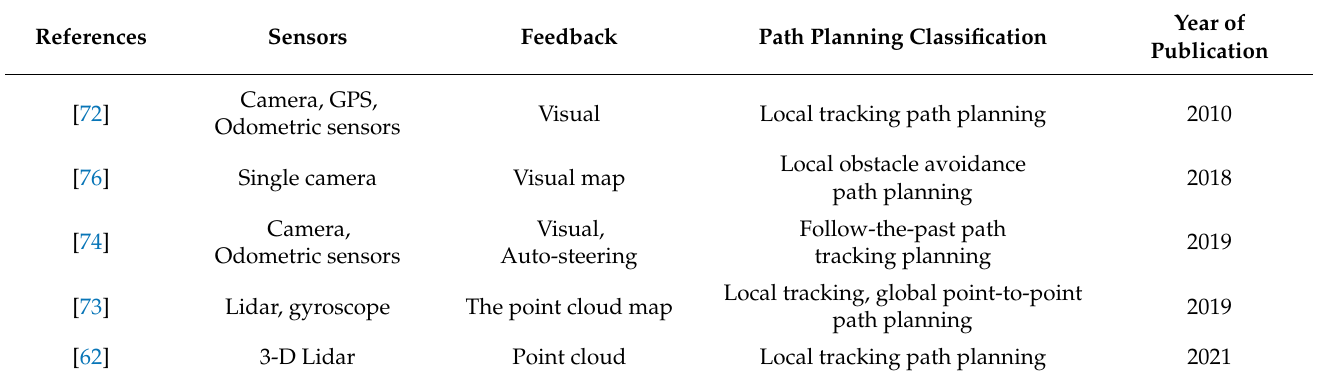
Table 4. Key components of articles related to path